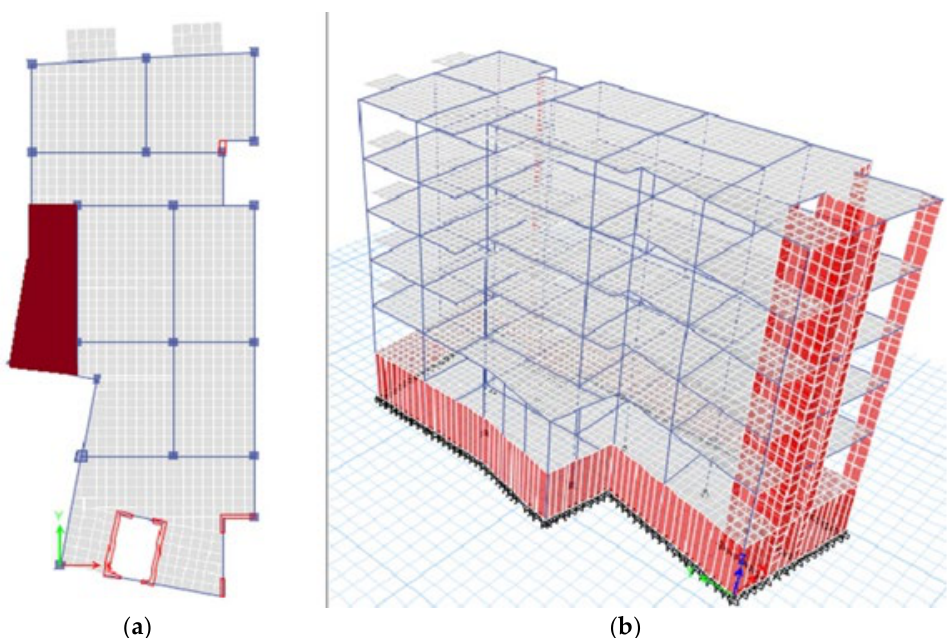
Figure 1. ETABS structural model [29,30]: ( a ) ground floor plan layout; ( b ) 3D-view.